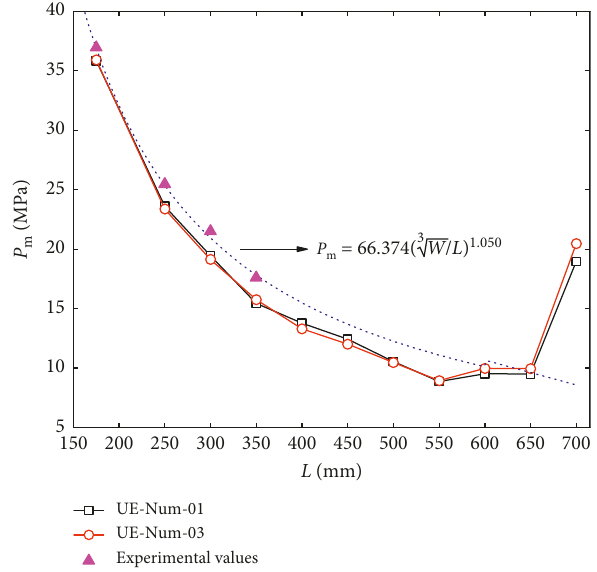
Figure 11: P m with L at different boundary